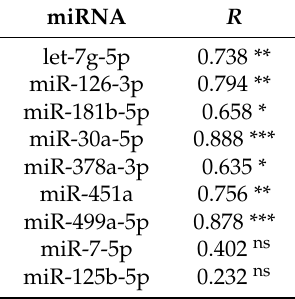
Table 6. The correlation coefficient of RNA-seq and qPCR data obtained for